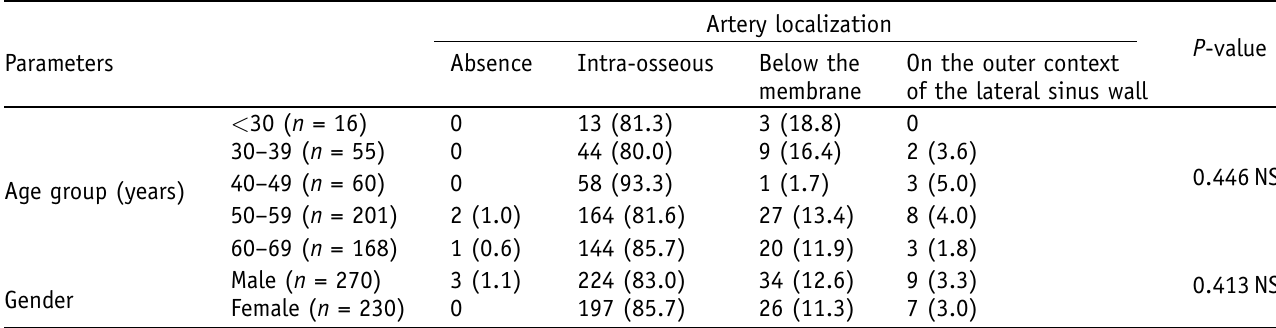
Table I. Distribution of artery localization according to age and gender (Chi square test).